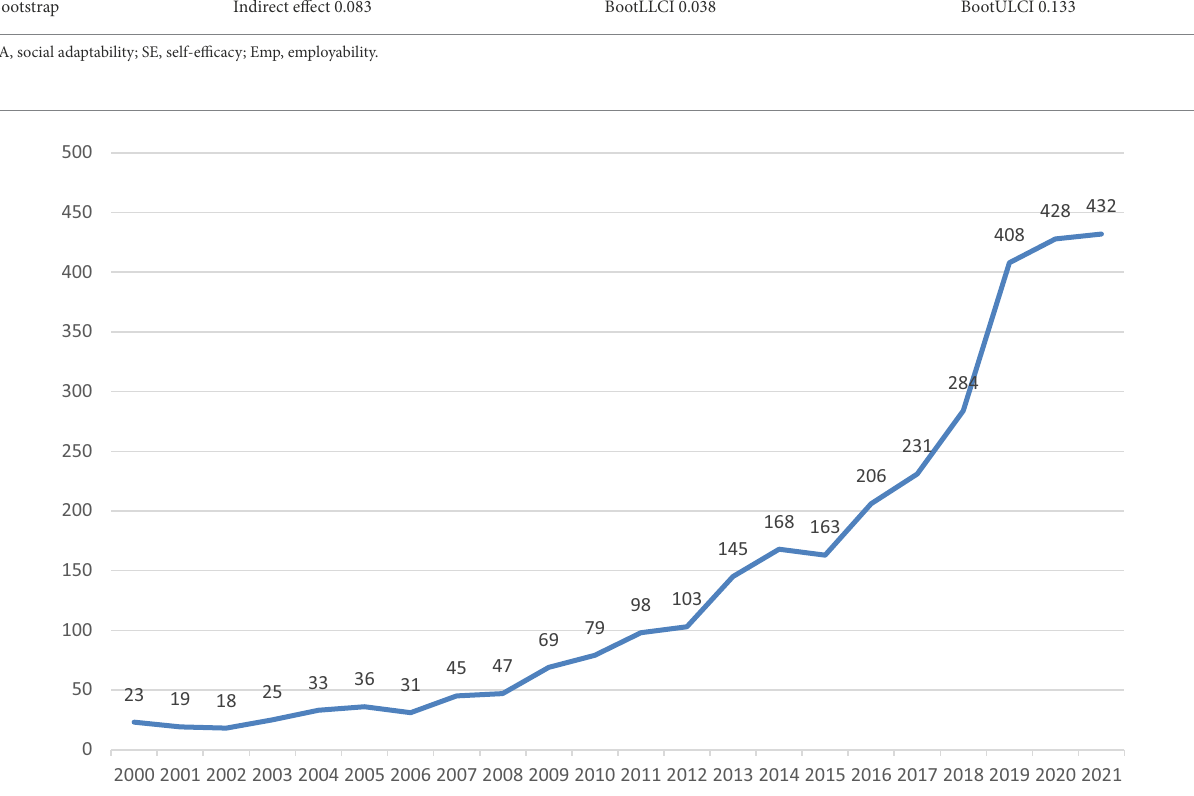
FIGURE 3 Publications of academic papers on employability between 2000 and